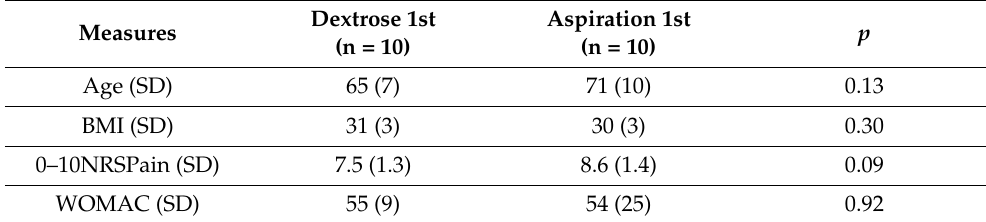
Table 1. Baseline Demographic Comparison Between